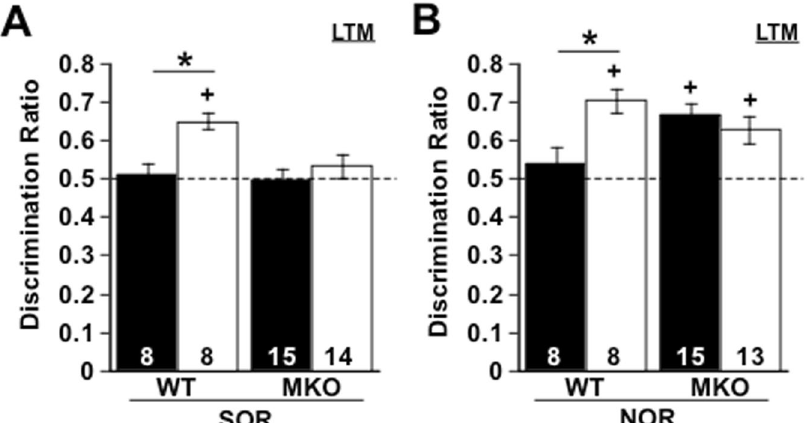
Figure 2. Melanopsin signaling contributes to photoperiodic changes in recognition memory. L20 enhanced Spatial Object Recognition (SOR, A ) and Novel Object Recognition (NOR, B ) memory in wild-type mice, but not melanopsin knockout mice (SOR: Full Factorial ANOVA Photoperiod: F(1,1) = 6.55, p <